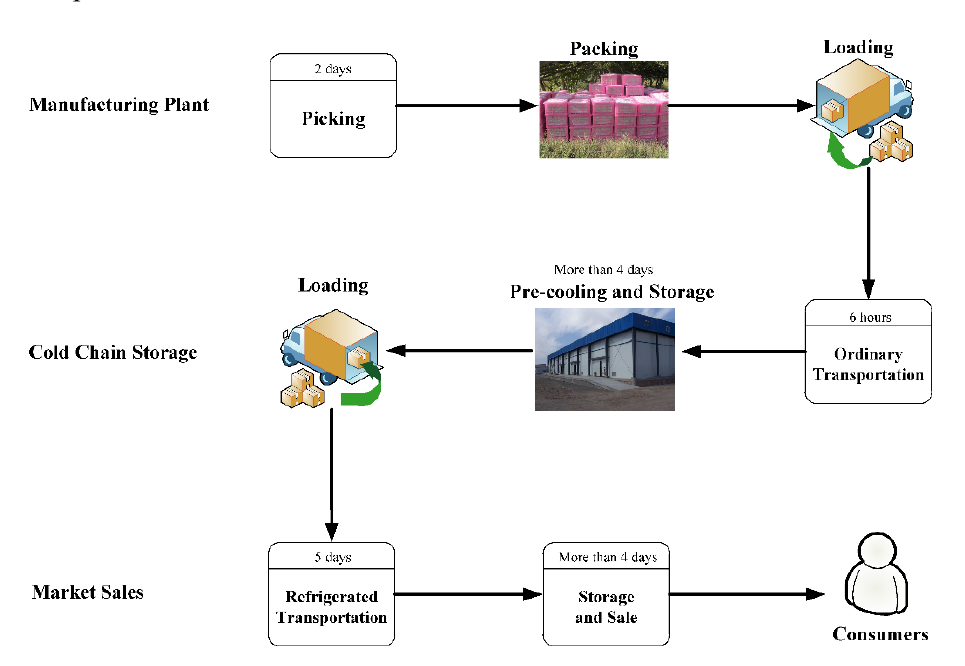
Figure 4. Process of table grapes’ cold chain